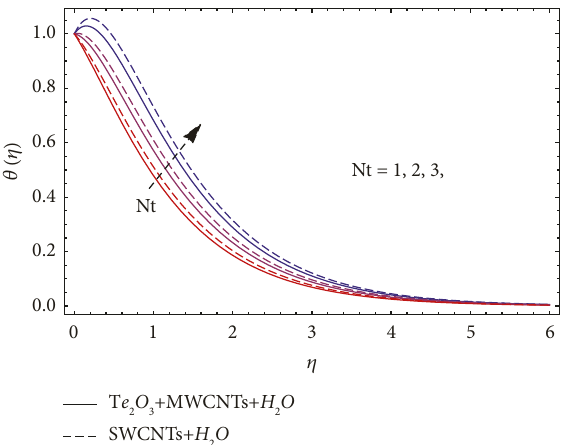
Figure 11: Influence of thermophoresis parameter on temperature profile.